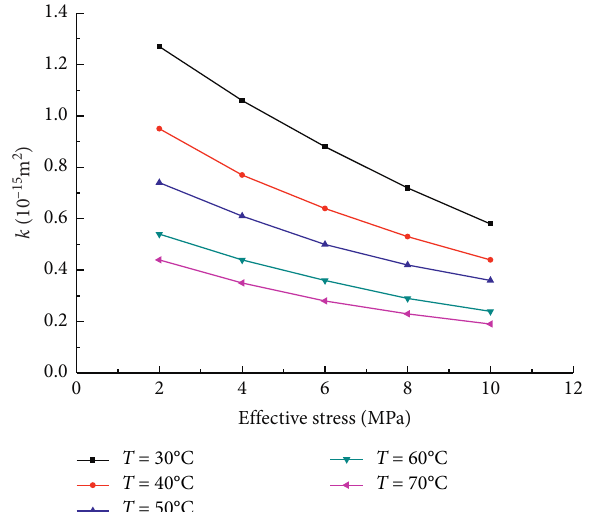
Figure 5: Percolation rate of coal with effective stress under different temperatures at the gas pressure of